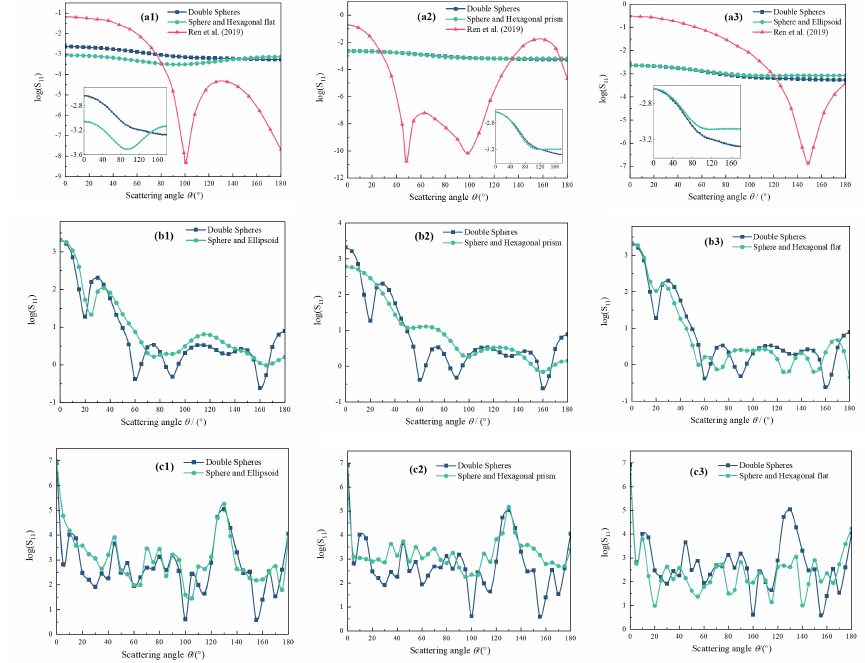
Figure 4. Influence of the shape of the ice crystals with aggregated structures on the laser scattering intensity [8]. ( a1 – a3 ) effective radius 0.1 λ µm; ( b1 – b3 ) effective radius λ µm; ( c1 – c3 ) effective radius. 10 λ